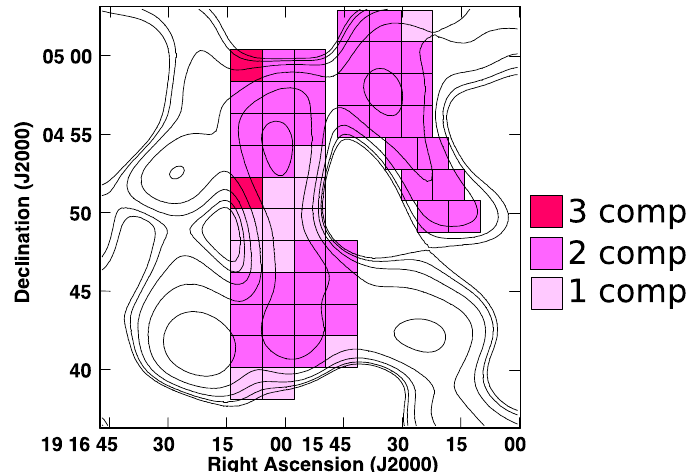
Figure 5. Spatial distribution of the total number of FDF components in the purple ( ϕ = − 112 to − 57 rad m − 2 ), blue ( ϕ = − 26 to 58 rad m − 2 ), cyan ( ϕ = 59 to 143 rad m − 2 ), and green ( ϕ = 144 to 228 rad m − 2 ) ranges of Faraday depth.